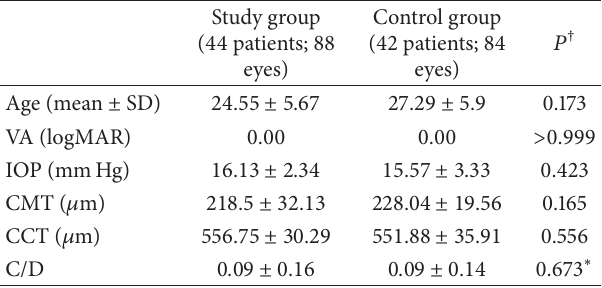
Table 1: Values of age, VA, IOP, CMT, and CCT of study and control groups.